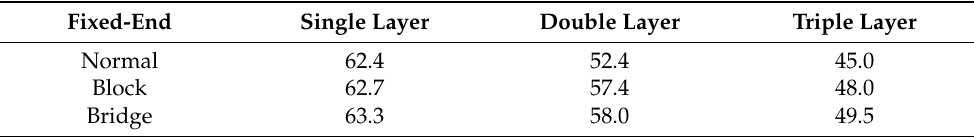
Table 1. Effective Young’s modulus of the as-fabricated Ti/Au micro-cantilevers by resonance frequency